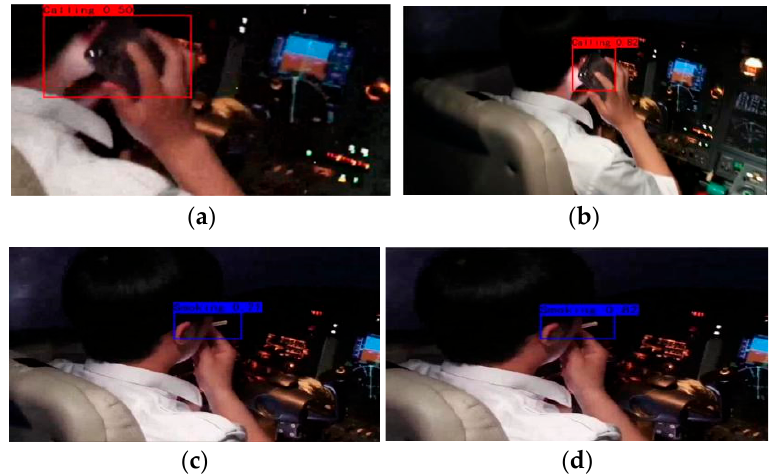
Figure 4. Object detection results using the YOLOv4 method ( a , c ) and object detection results using our proposed method ( b , d ) .